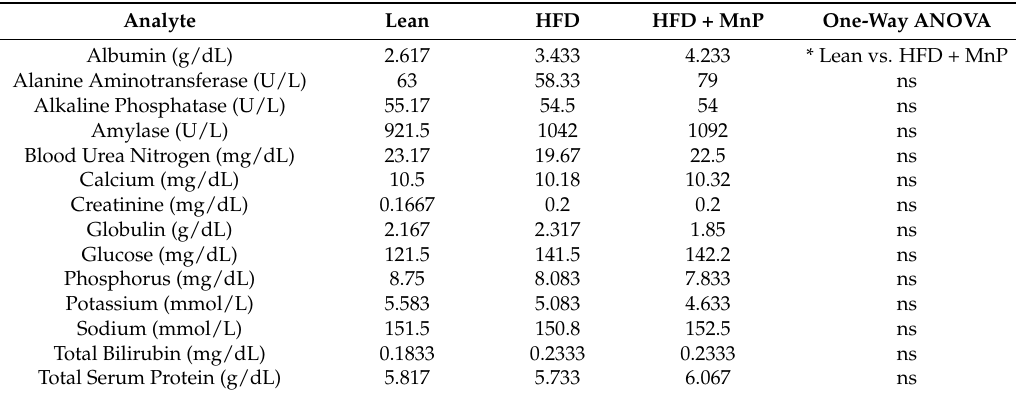
Table 1. MnP treatment exhibits minimal toxicity.